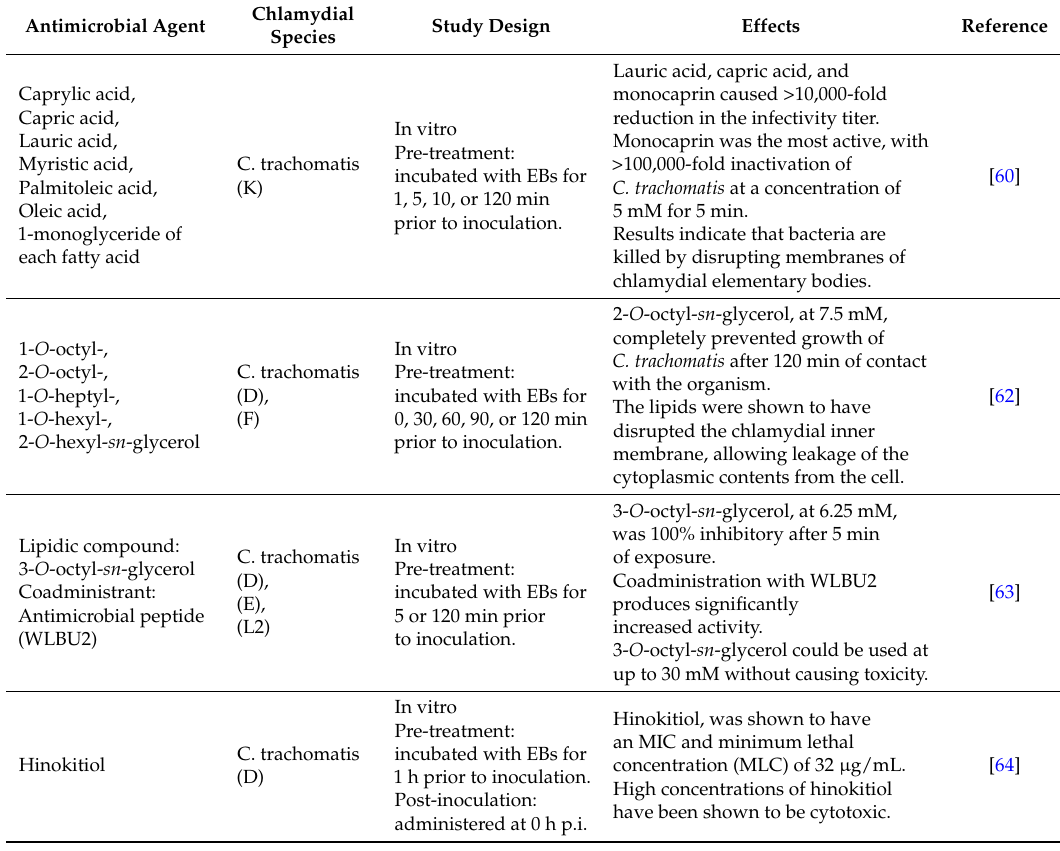
Table 3. Past studies exploring antichlamydial properties of lipidic